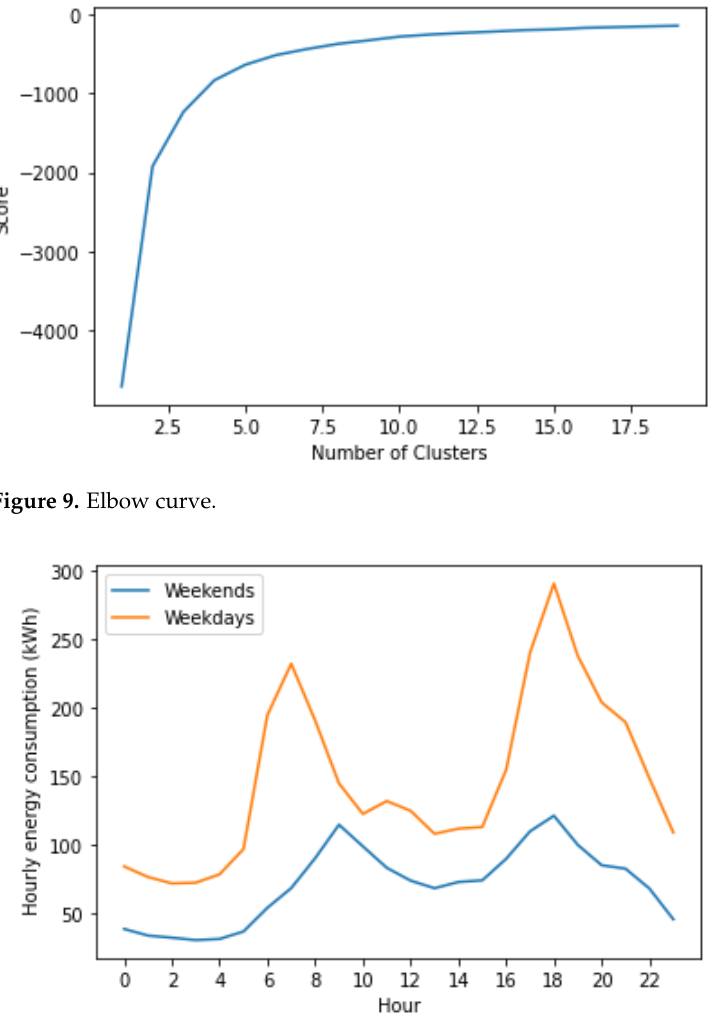
Figure 10. Average daily energy consumption (weekends and